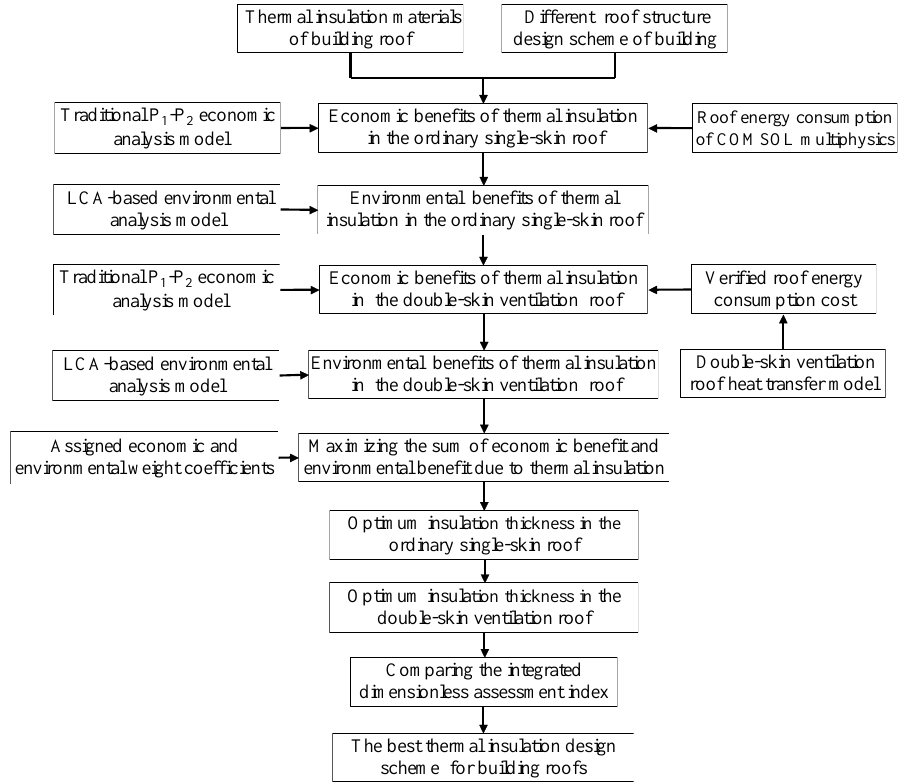
Figure 1. Block diagram of optimization design method for roof insulation.